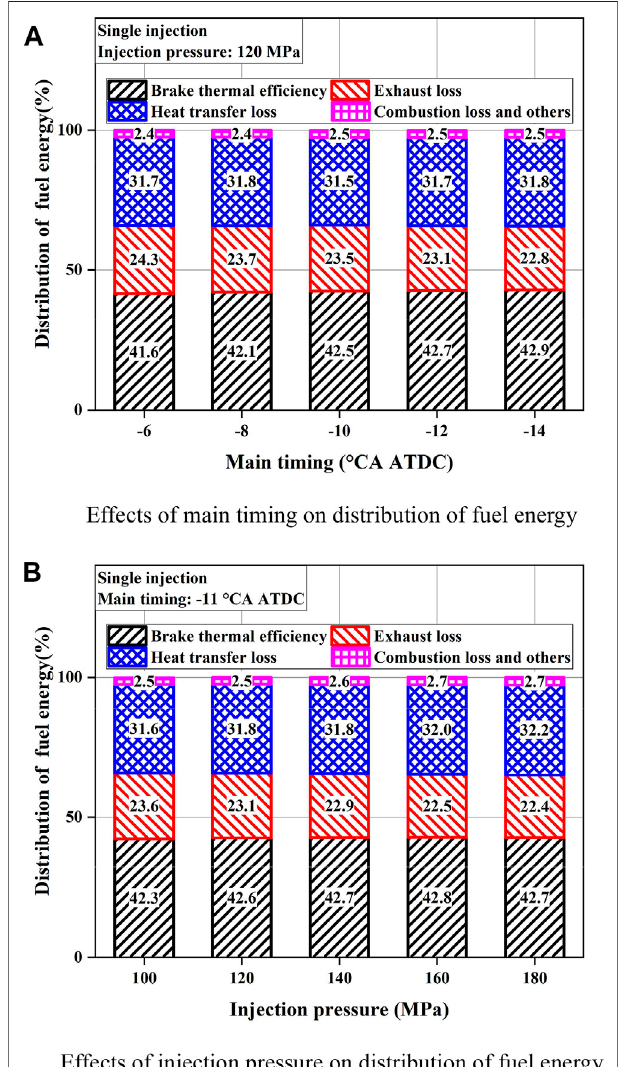
FIGURE 3 | Effects of single main injection timing and pressure on distribution of fuel energy. (A) Effects of main timing on distribution of fuel energy, (B) Effects of injection pressure on distribution of fuel energy.